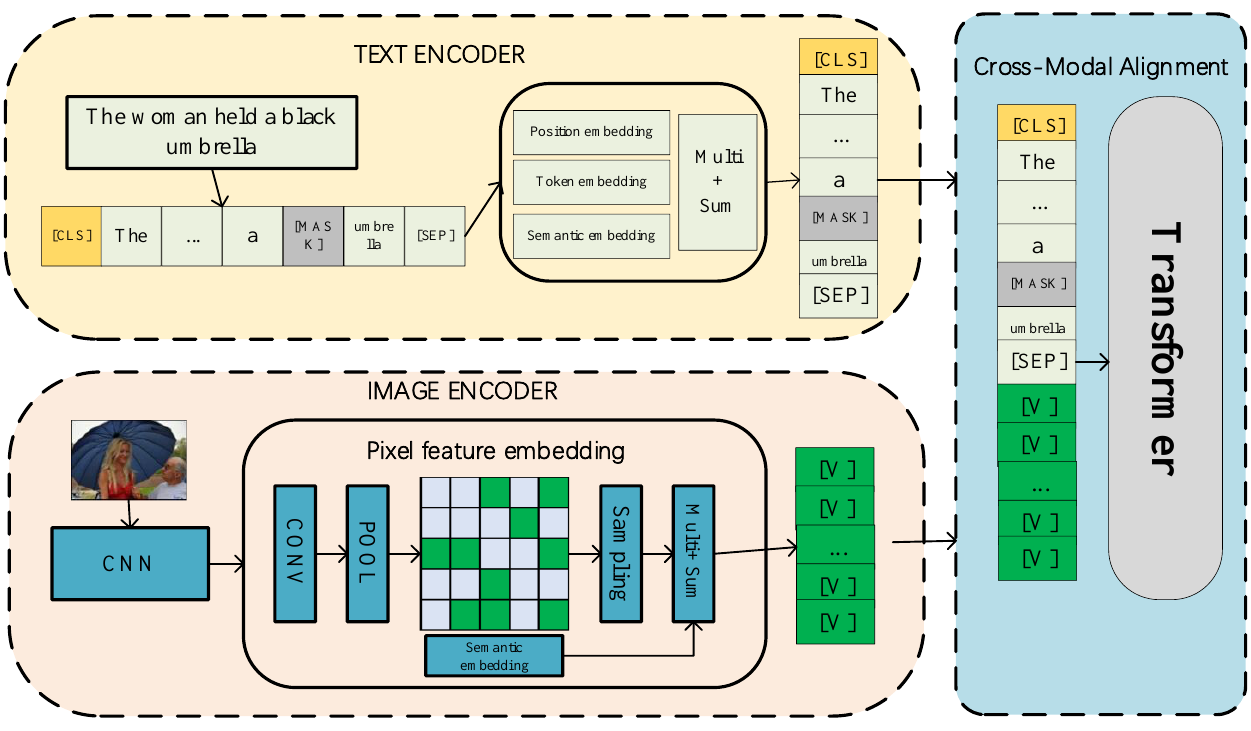
Figure 8. Overview of Pixel-BERT architecture.